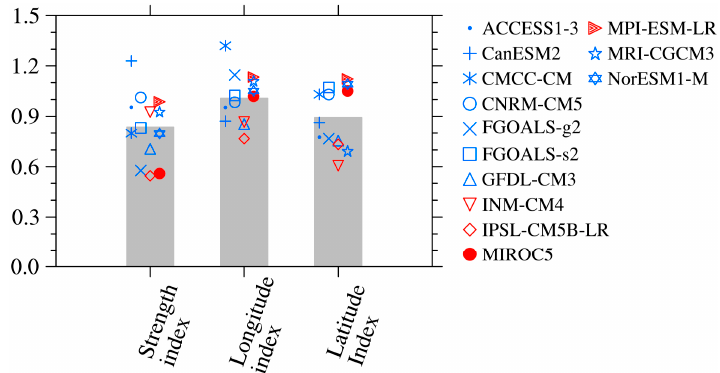
Figure 7. Difference of ( a ) strength index, ( b ) longitude index and ( c ) latitude index of winter climatological mean between the CMIP5 models and NCEP reanalysis.